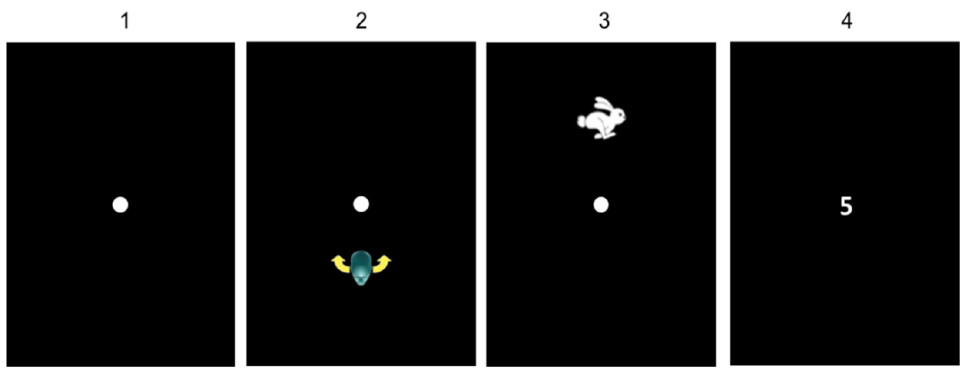
Figure 3. Gym exercise.